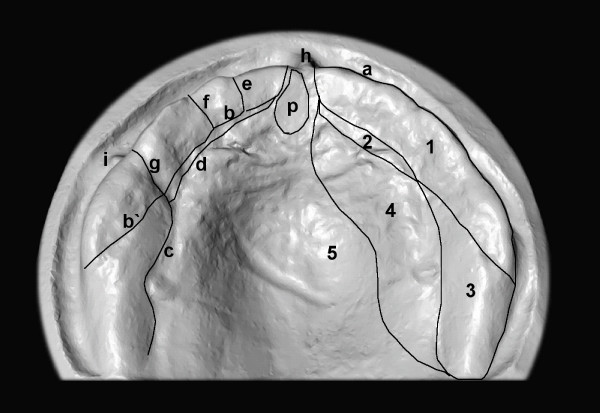
The alveolar portion of the upper gum pad is separated from the palate by a groove. The alveolar portion itself is again divided into buccal and lingual portions which are also separated by grooves. The former is the larger, participates in the formation of the sheath and socket of the teeth, and is further divided by transverse grooves or sulci into segments corresponding to the developing tooth germs. For nomenclature of palatal structures, see Table 2 (Additional file 2). Interestingly, the 'Terminologia Anatomica' contains for discription of palatal structures only the following terms: Frenulum labii superioris (Frenulum of upper lip); Palatum (Palate); Palatum durum (Hard palate); Palatum molle, Velum palatinum (Soft palate); Raphe palati (Palatine raphe); Plicae palatinae transversae, Rugae palatinae (Transverse palatine folds; Palatine rugae); Papilla incisiva (Incisive papilla).